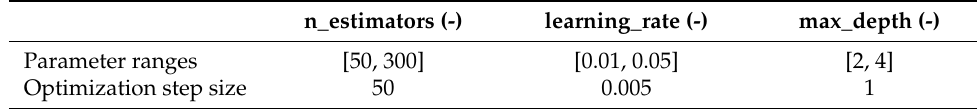
Table 2. Criterion used for optimizing the GBRT